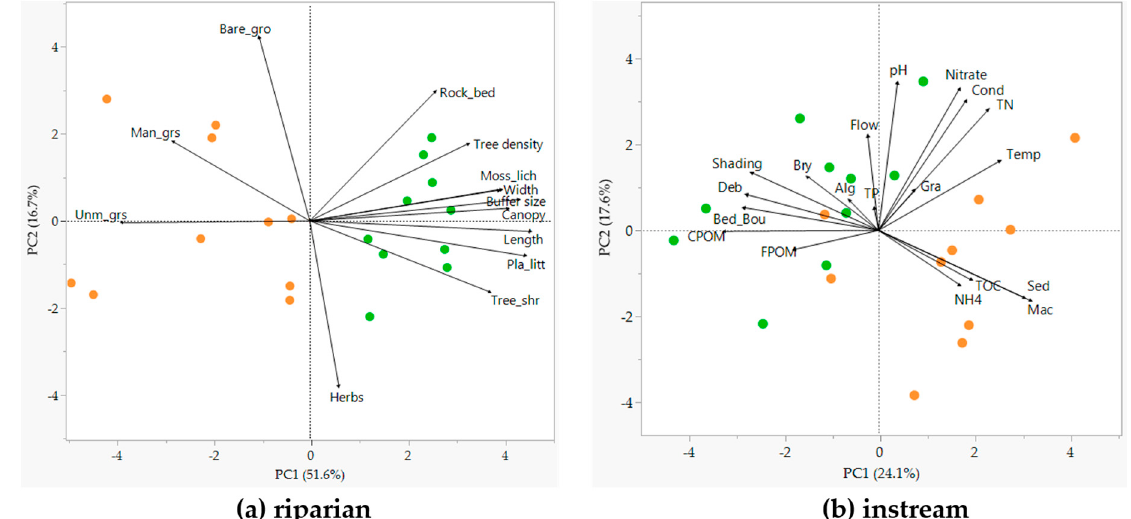
Figure 2. Principal Components Analysis (PCA) of the unbuffered and buffered reaches using selected environmental variables for: ( a ) riparian; and ( b ) instream habitats. Orange dots represent unbuffered and green dots represent buffered reaches. Abbreviations: riparian ( a ): Bare_gro = Bare ground (%), Man-grs= managed grass (%), Moss_lich = moss/lichens (%), Pla_litt = plant litter (%), Rock_bed = rocks/bedrock (%), Tree_shr = trees/shrubs (%), Unm_grs = unmanaged grass (%). Abbreviations: instream ( b ): CPOM = coarse particulate organic matter, FPOM = fine particulate organic matter, TOC = total dissolved carbon, Cond = conductivity, TP = total phosphorus, TN = total nitrogen, Alg = algae (%), Bed_Bou = Bedrock, boulders (%), Bry = bryophytes (%), Gra = gravel (%), Mac = macrophytes (%), Sed = fine sediment